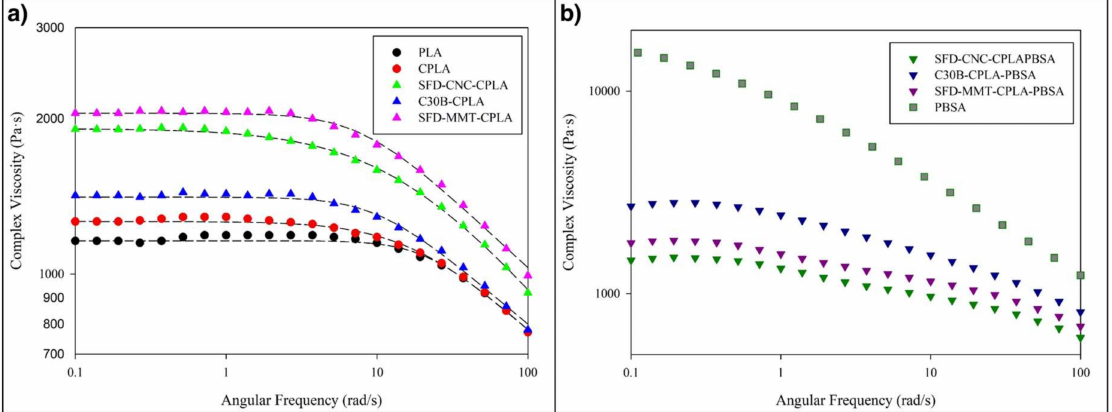
Figure 4. Complex viscosity of the ( a ) PLA, chain-extended PLA (CPLA), and CPLA